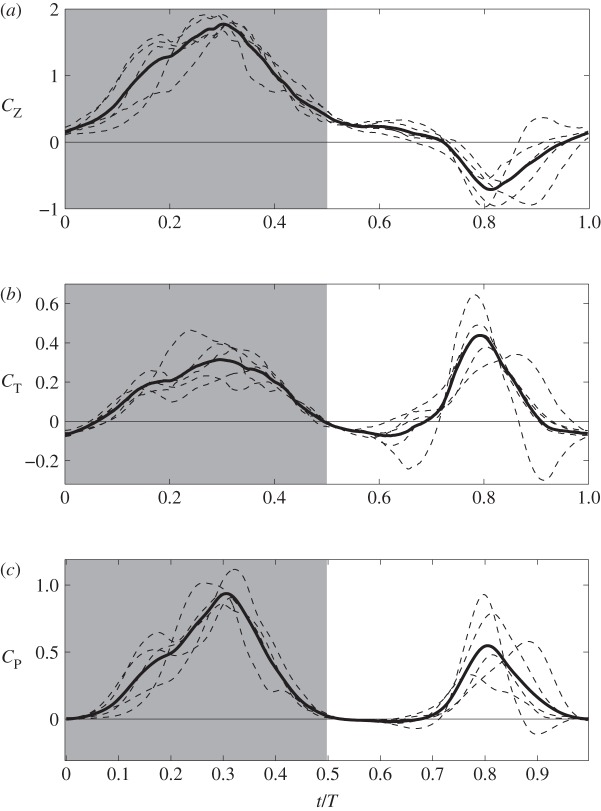
Force production and aerodynamic power consumption of each hummingbird wing: (a) vertical force coefficient, (b) thrust coefficient and (c) power coefficient. In each case, the thin dashed lines are the instantaneous data, and the thick line is the phase-averaged data.